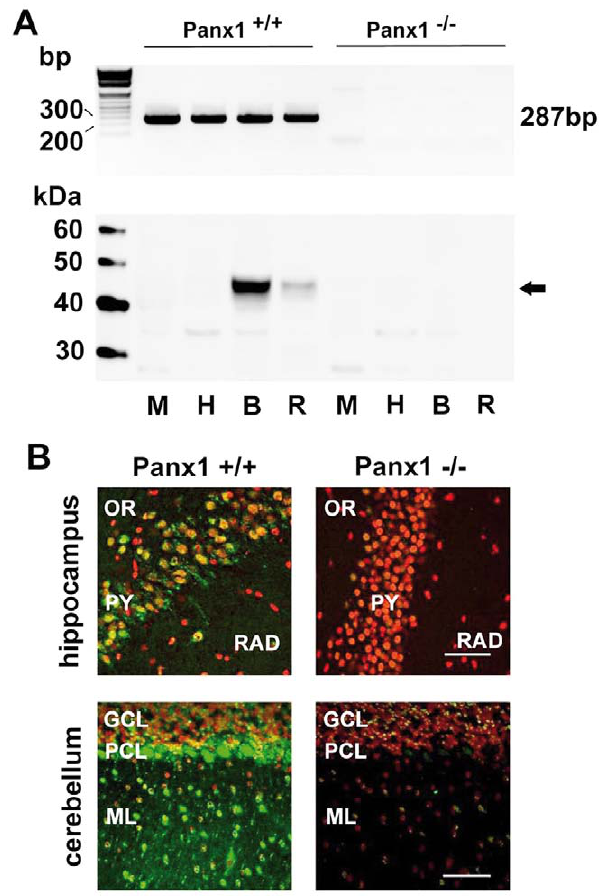
Figure 1. Characterization of Panx1 2 / 2 mice. a, RT-PCR and western blot analysis of 4 adult Panx1 + / + control and Panx1 2 / 2 animals. Note the lack of the 287 bp PCR amplicon representing the deleted exon4 in the Panx1 mRNA and the loss of the Panx1 protein in Panx1 2 / 2 mice. b, Immunohistochemistry demonstrating loss of Panx1 protein expression in CA1 region of the hippocampus and cerebellum. Abbreviations: M, muscle, H, heart, B, brain, R, retina, OR, stratum oriens, PY, stratum pyramidale, RAD, stratum radiatum, GCL, granular cell layer, PCL, Purkinje cell layer, ML, molecular layer. Scale bars: 100 m